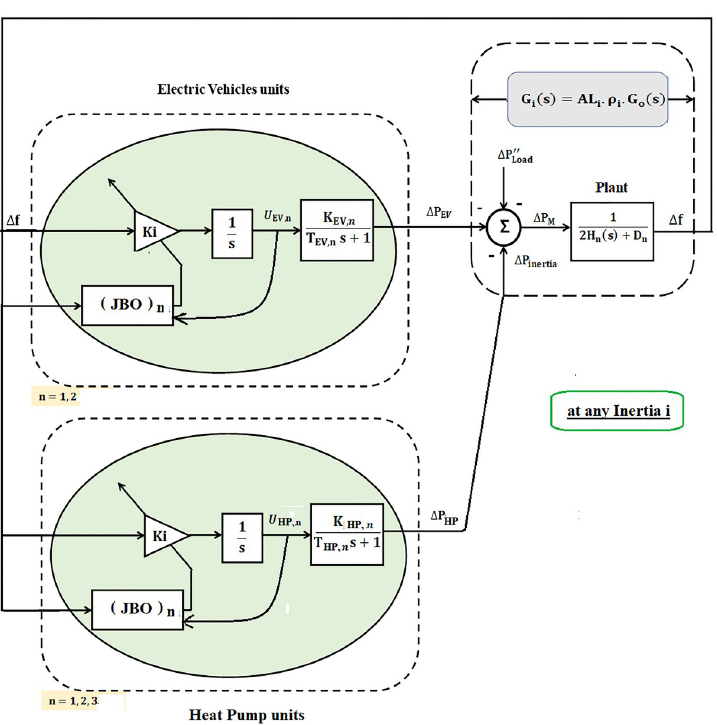
Fig 6. Simplified microgrid model-based adaptive control system supported by BE for EVs and HPs.